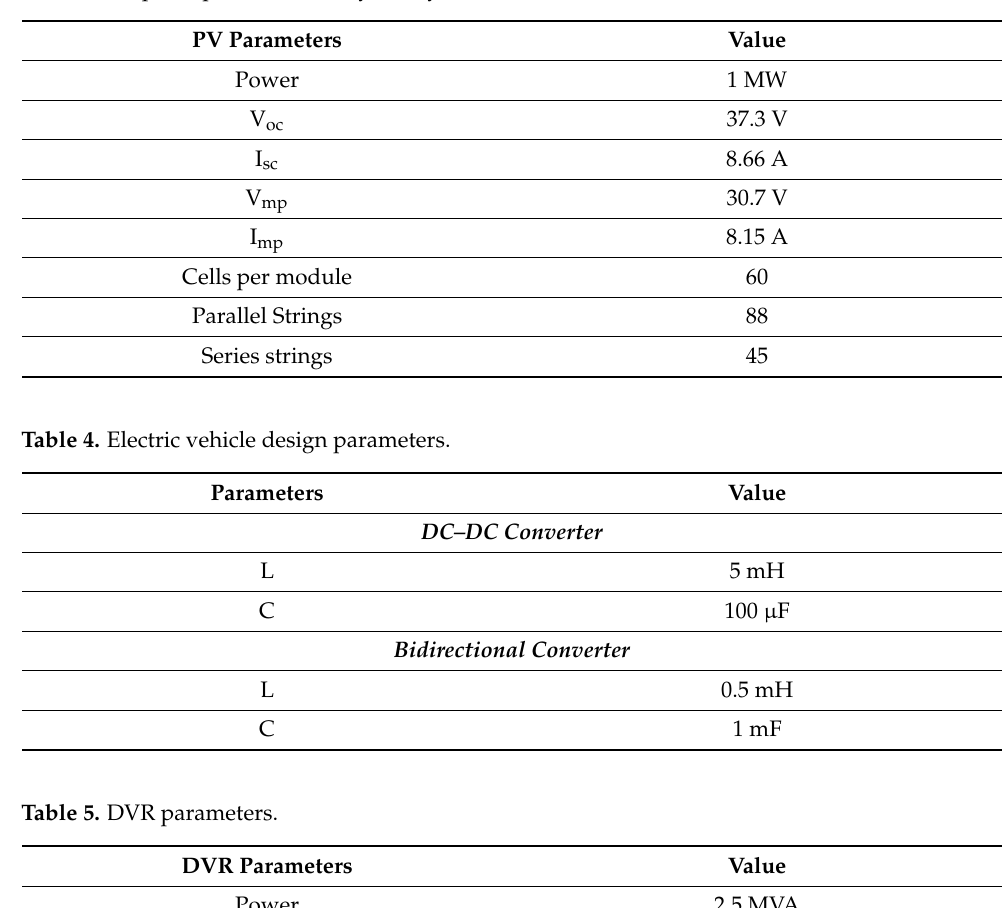
Table 3. PV panel parameters of hybrid system and electric vehicle.